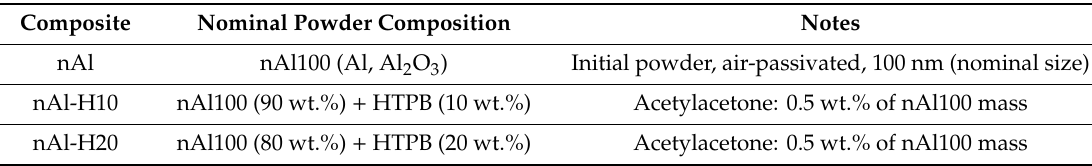
Table 2. The composition of the initial and composite